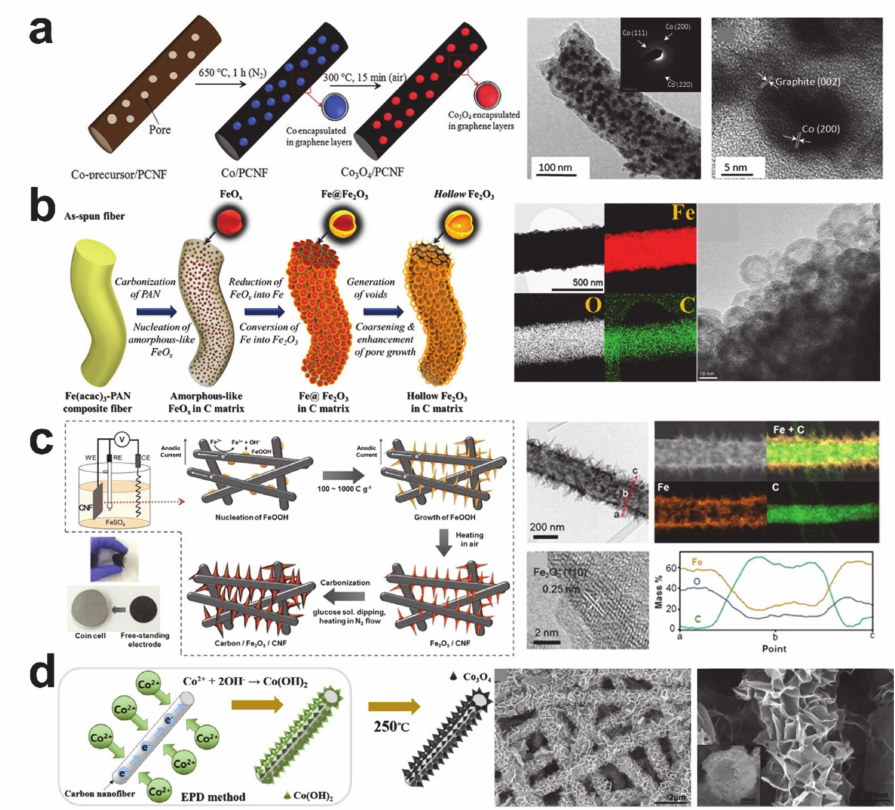
Figure 10. Transition metal oxide / carbon composite nanofibers. ( a ) Co 3 O 4 / porous carbon